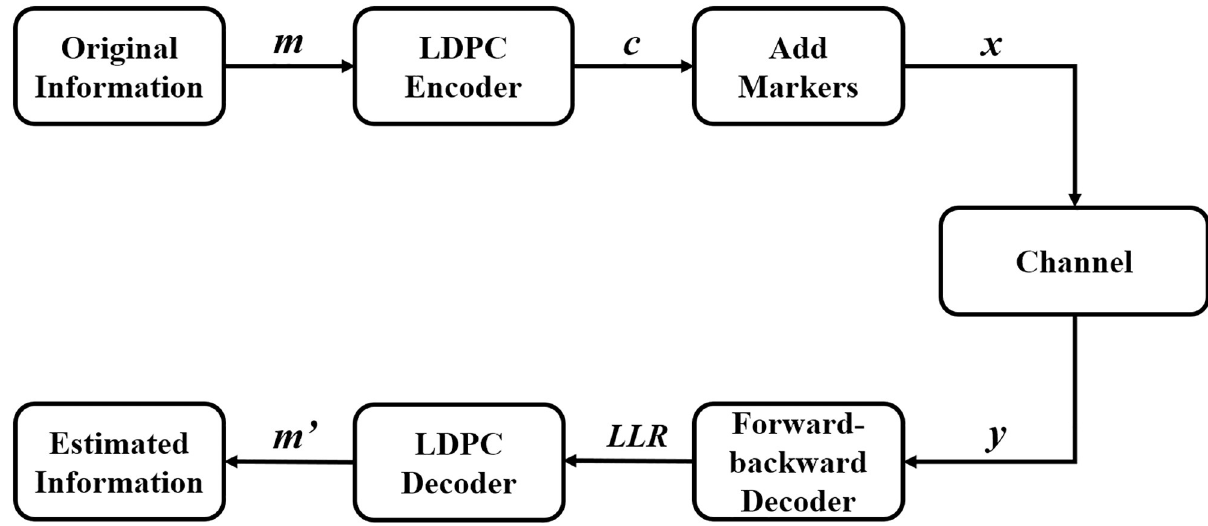
Fig 2. Flow chart of the encoding and decoding of the concatenated LDPC-marker code.